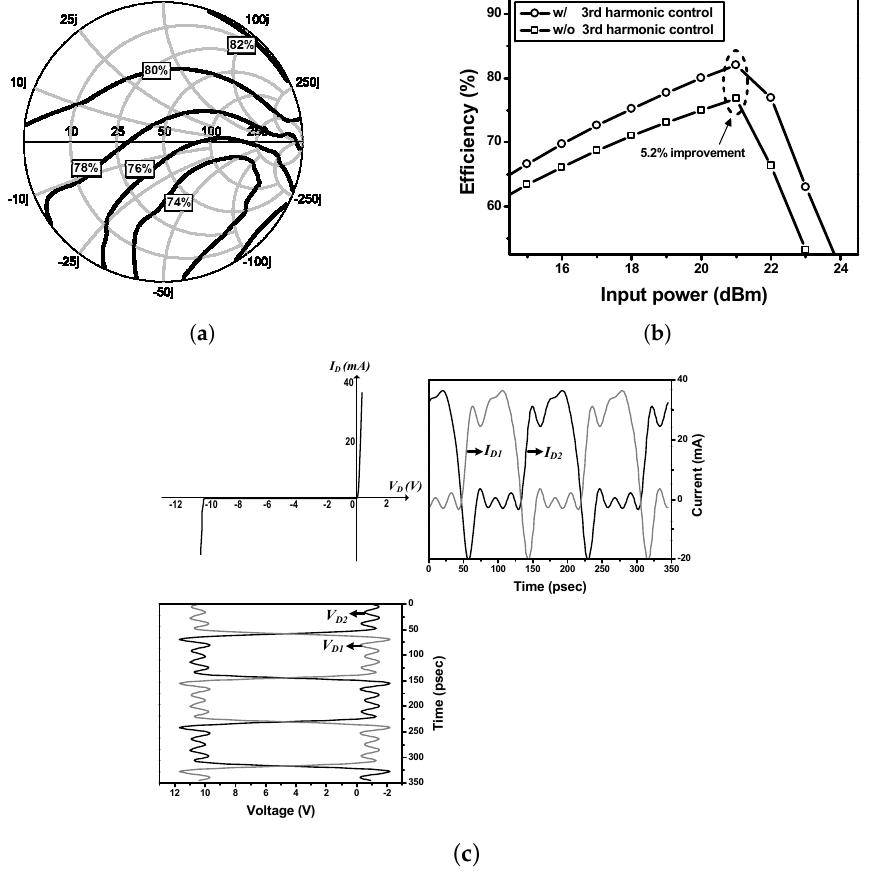
Figure 5. Simulation results of the class-F voltage doubler, ( a ) efficiency contours for the input third harmonics; ( b ) simulated efficiencies; and ( c ) voltage and current waveforms of the Schottky